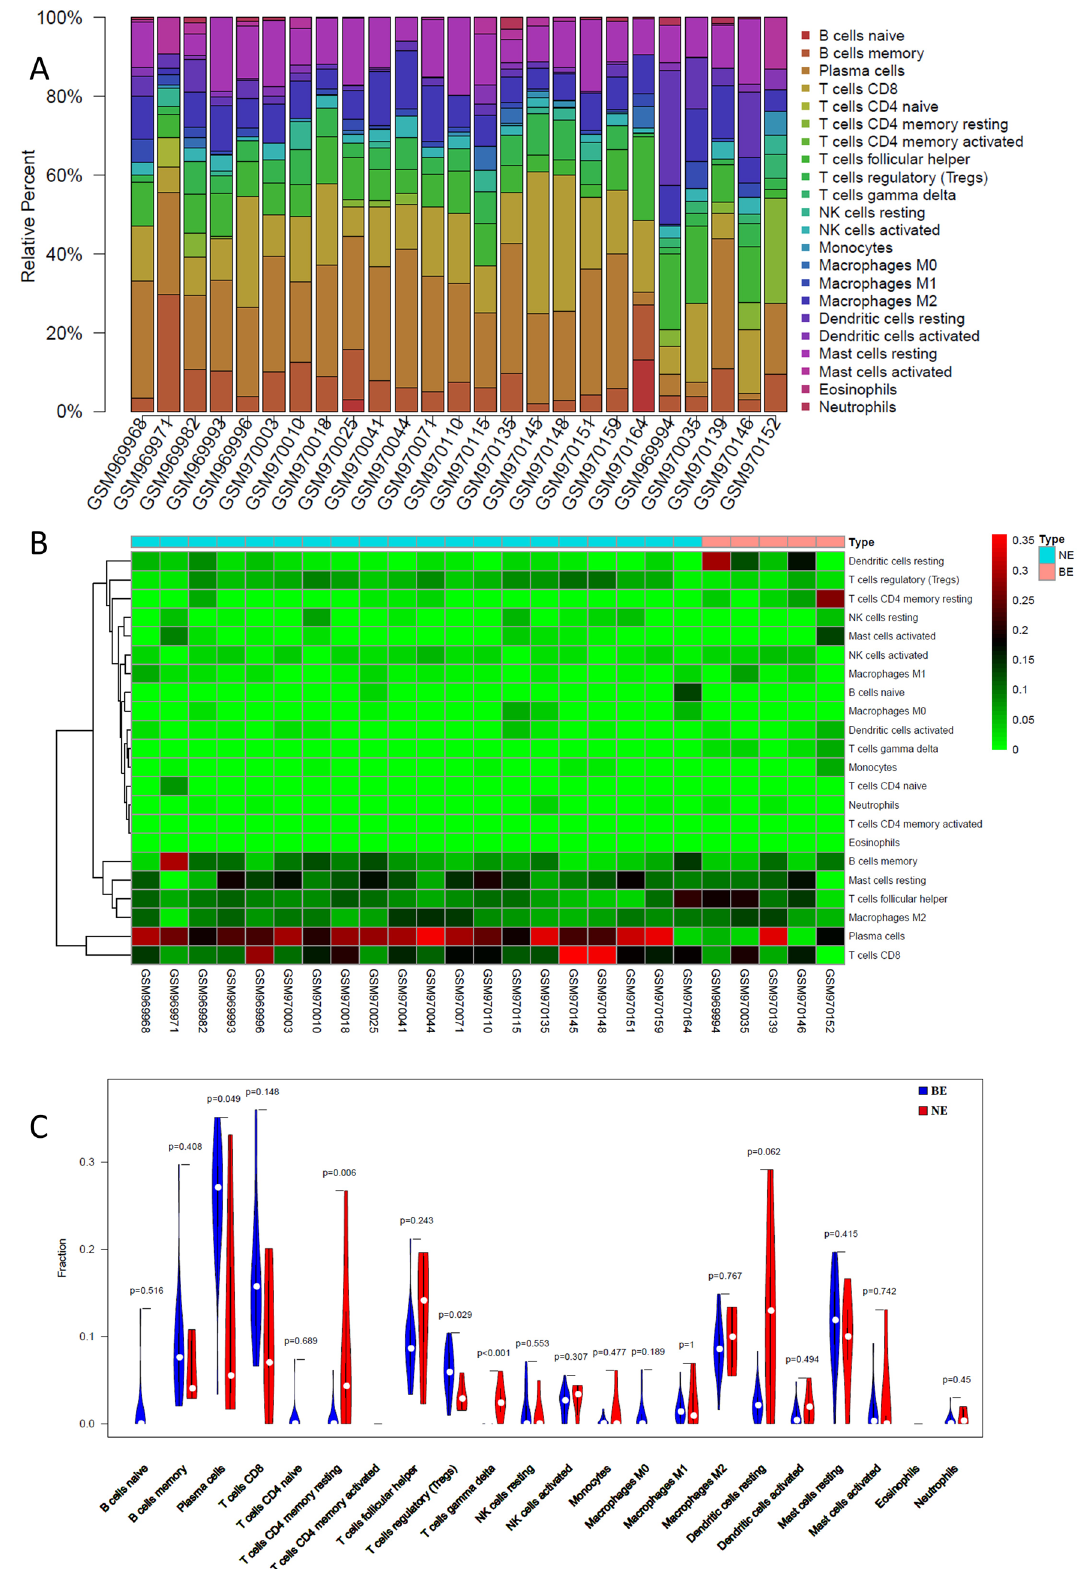
Figure 5. Distribution of immune cells between BE and NE samples. ( A ) Percentage of immune cells in each sample. ( B ) Heatmap. ( C ) Violin